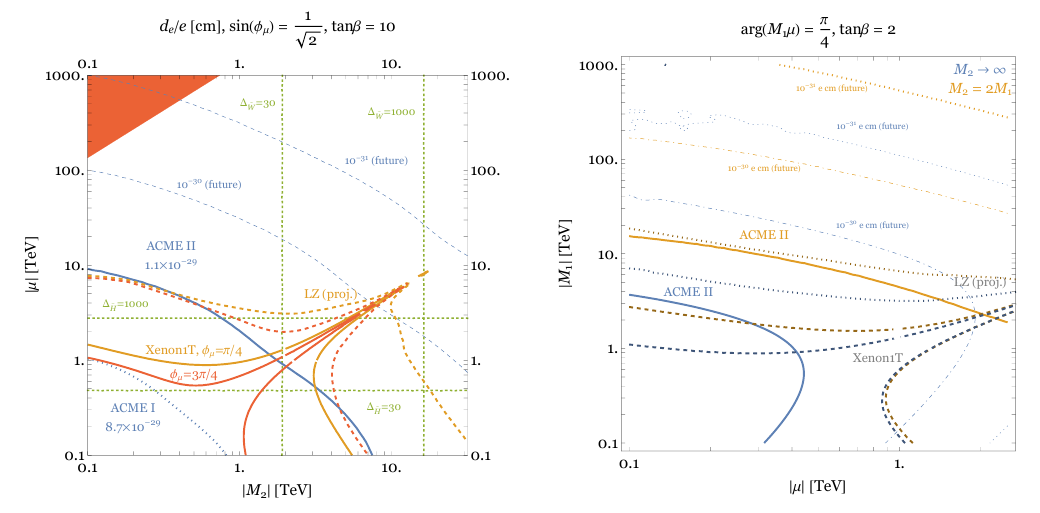
Figure 5 . Constraints on electroweakinos from EDMs and from dark matter direct detection in the case of a large CP-violating phase, sin( (cid:30) (cid:22) ) = 1 = p 2. Left-hand panel: bounds as a function of M 2 and (cid:22) , assuming M 1 = M 2 = 2. We have (cid:12)xed tan (cid:12) = 10 for relatively weak EDM constraints. j j j j The orange Xenon1T and LZ curves are for (cid:30) (cid:22) = (cid:25)= 4 while the red curves are for (cid:30) (cid:22) = 3 (cid:25)= 4, where the direct detection constraints are weaker. We see that the EDM constraint is generally stronger except near the diagonal. The green dashed curves are (cid:12)ne-tuning contours and the upper-left triangular region requires tuning away a threshold correction to M 2 ; see ([39], section 6.1) for further discussion. The dashed \future" curves represent hypothetical future improvements, possibly arising from experiments with polyatomic molecules [63]. Right panel: bounds as a function of M 1 with tan (cid:12) = 2. Here we present two scenarios, one with M 2 = 2 M 1 and one where winos j j are decoupled ( M 2 , see [64]). Decoupling the winos removes the dominant ( (cid:13)h ) ! 1